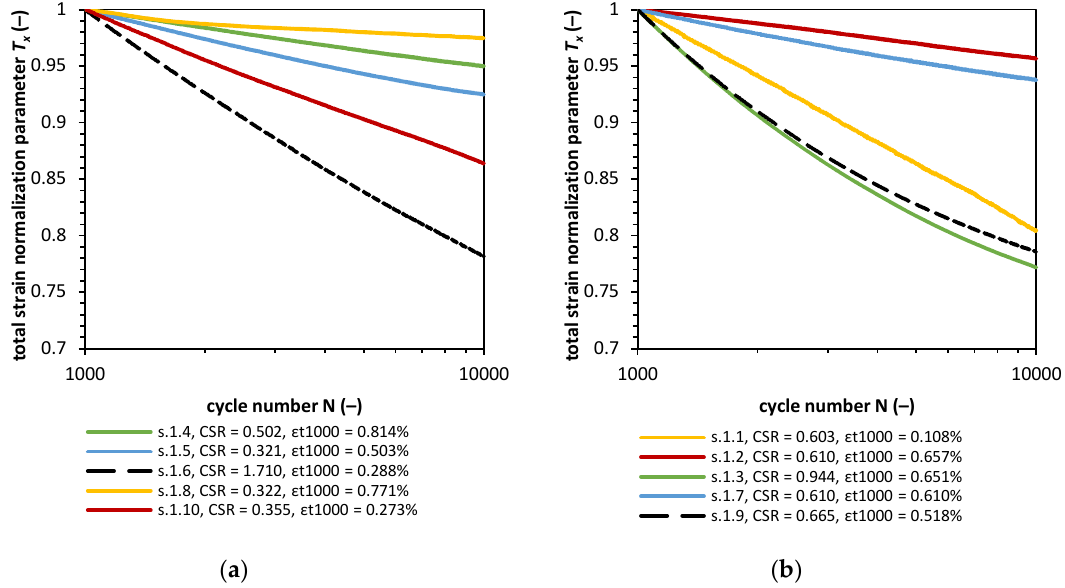
Figure 10. Total strain normalization parameter in reference to cycle 1000 T x,1000 in confining pressure equal to 18, 90, and 135 kPa ( a ), and for the samples consolidated with confining pressure at around 45 kPa ( b